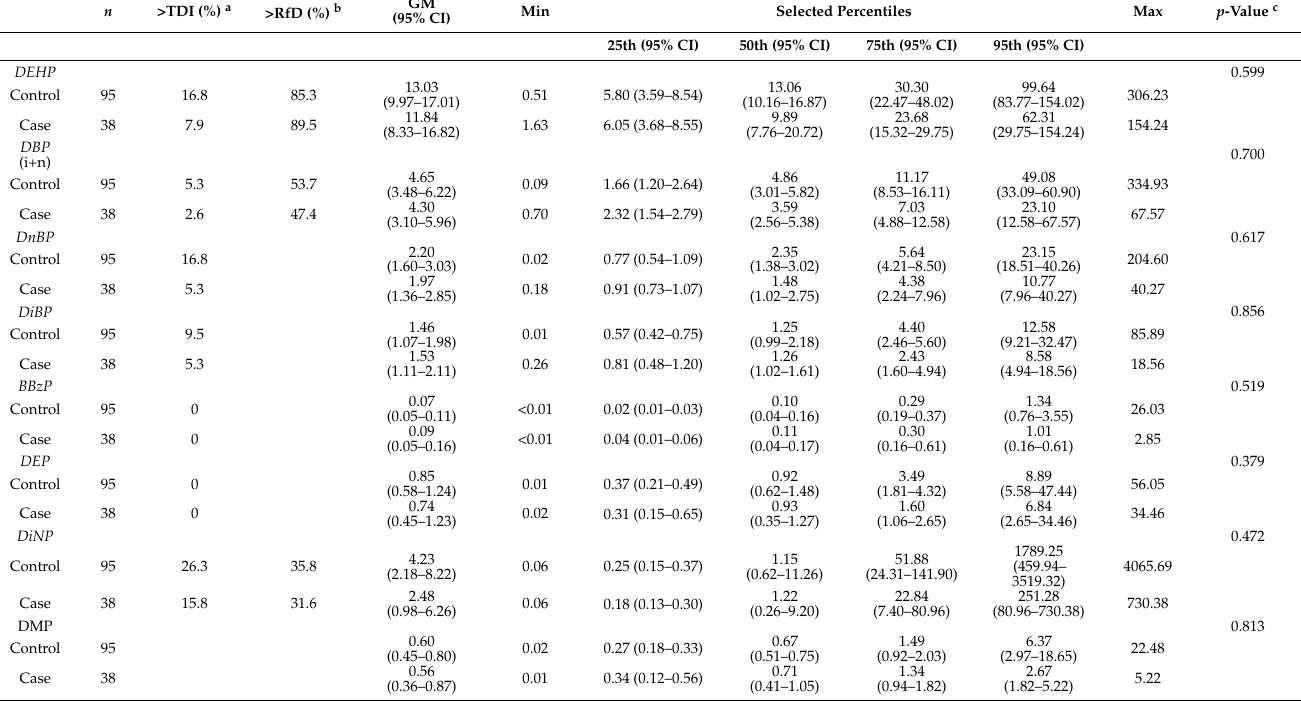
Table 4. Levels of estimated daily phthalate intakes ( µ g/kg/day) for control and case groups.